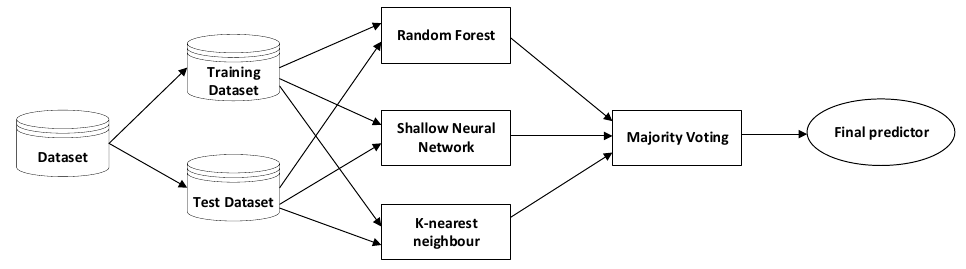
Figure 5. Ensemble of classifier for real-time